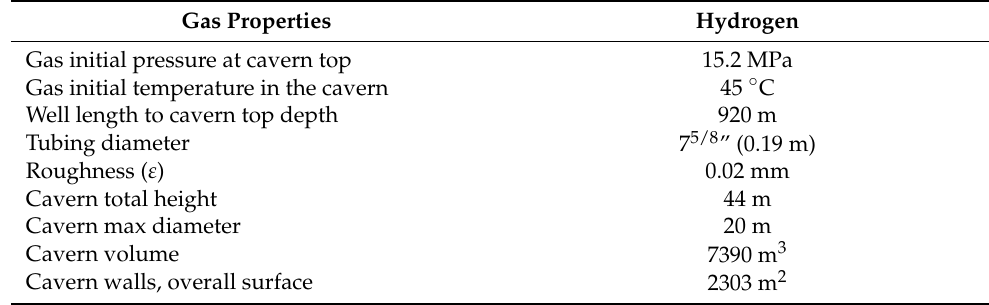
Table 2. Properties of the EZ53 salt cavern to be used for blowout numerical computations [17].